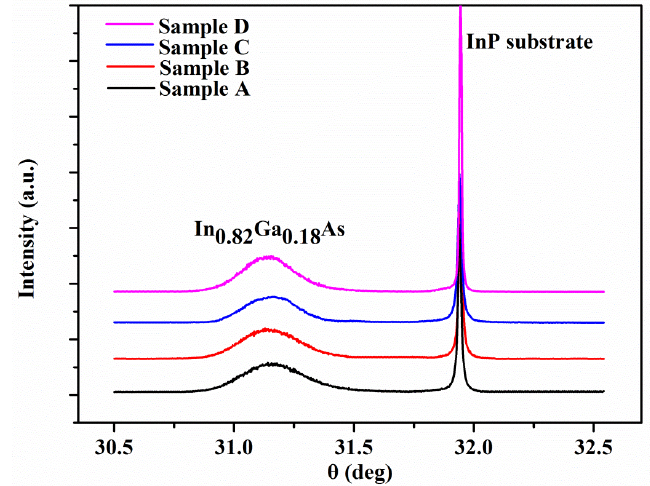
Figure 2. The double-crystal X-ray diffraction (DC-XRD) ω scans of In 0.82 Ga 0.18 As epitaxial layers grown on InP (100) substrates for sample A–D.